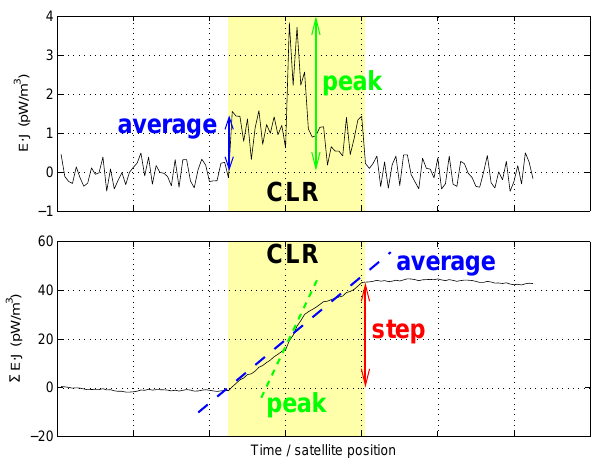
Fig. 1. Schematic CLR as it would be observed in the power density data. The top panel shows the power density and the bottom panel contains the cumulative sum of the power density along the satellite path. The quantities peak and average correspond to the maximum and average value of the time series of the power density, and hence the maximum and average slope in the cumulate sum of the power density along the spacecraft path. The step size measures the in- crease in the cumulative sum. Figure from Hamrin et al. (2009a). the spacecraft path) of the power density as shown in the bot- tom panel. A CGR behaves similarly, but the power density is